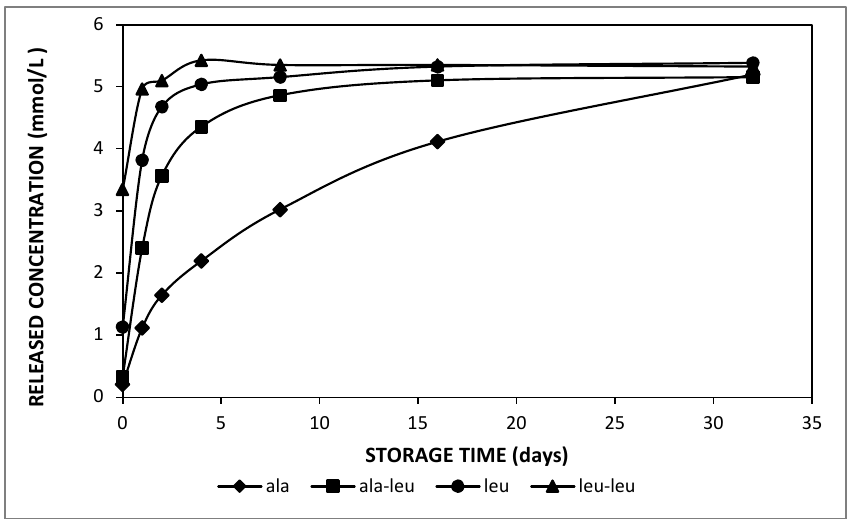
Figure 5. Released concentration in the external phase of double emulsions containing alanine (diamonds), L-alanine–L-leucine (squares), leucine (circles) and L-leucine–L-leucine (triangles) prepared with HOSO at pH 7 during storage at 37 °C. Table 3. Chemical properties of the amino acids and di-peptides used; the octanol–water partition coefficient (Log Pow) is an indicator of hydrophobicity of the amino acids and